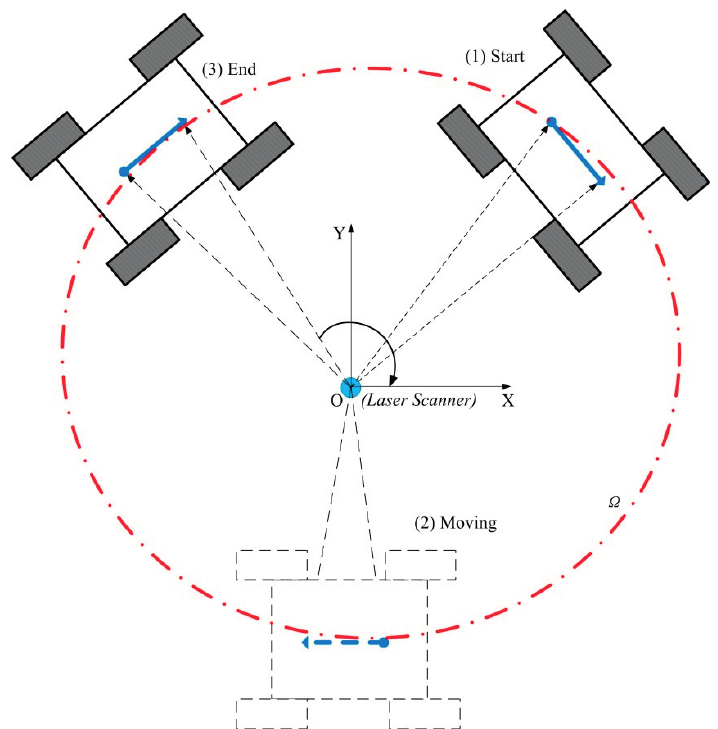
Figure 9. The laser scanner measurement during an entire cycle (cid:2007) run from ( 1 ) start to ( 3 ) end with the mobile